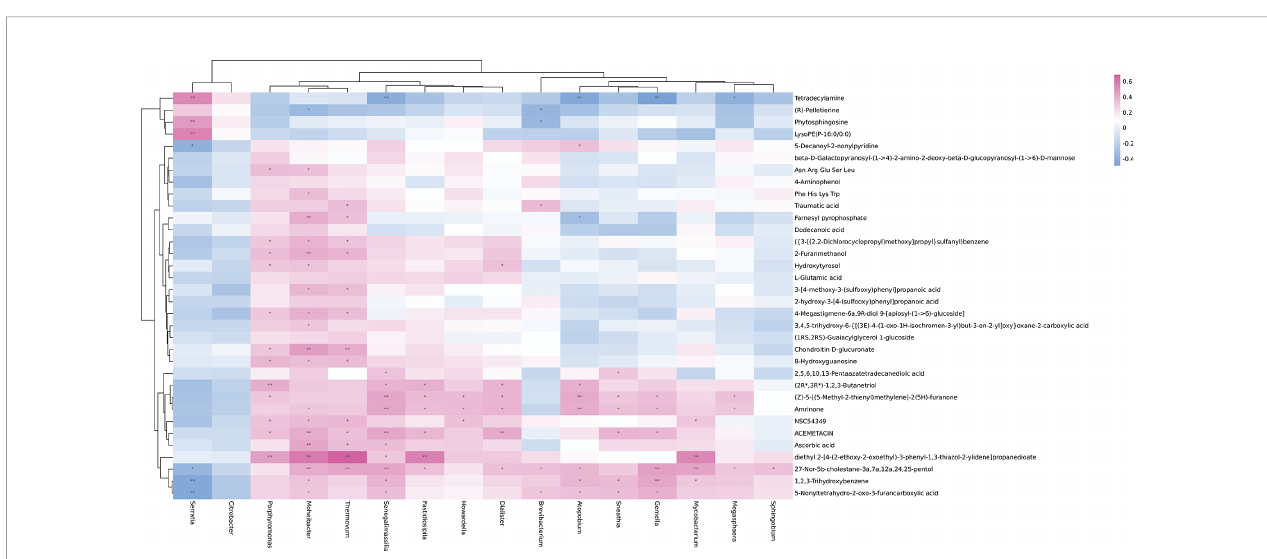
FIGURE 4 | Heatmap of Spearman ’ s rank correlation coef fi cients of the relative abundances of different urinary microbiota at the genera level and urinary metabolites in controls and IC patients. Red box = positive correlations; blue box = negative correlations.